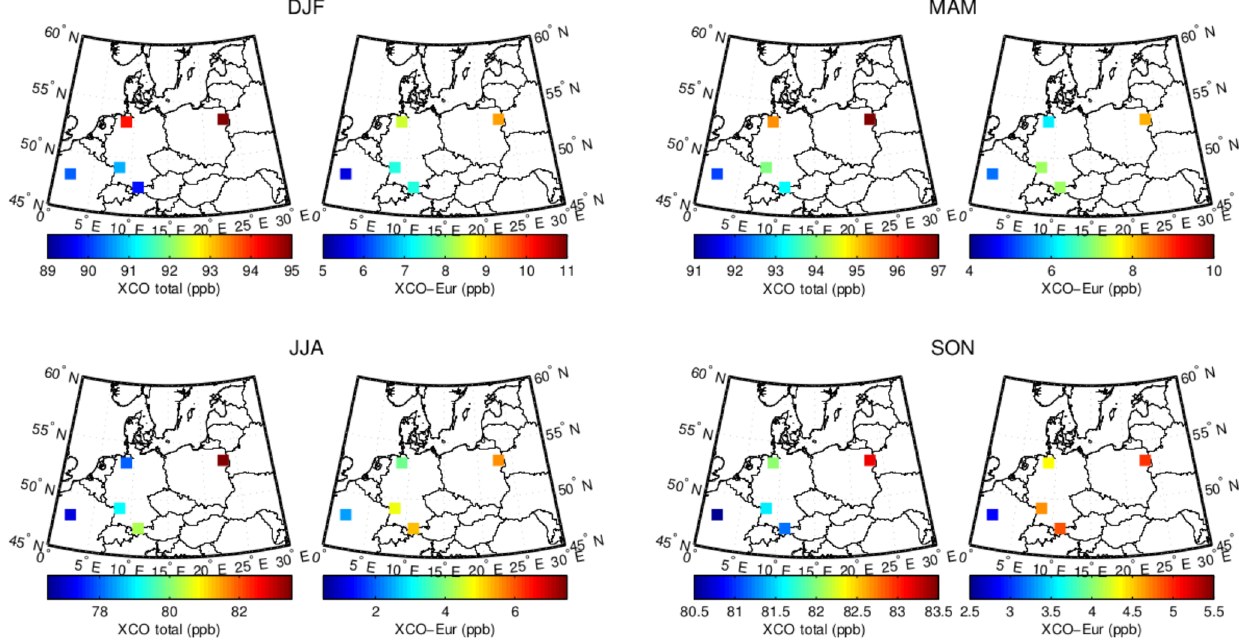
Figure 4. This figure compares seasonally averaged modeled total X CO with the X CO contribution from emissions in Europe. Each season has two maps: the left map shows the total X CO and the right map shows the contribution from European emissions (X CO − Eur ). The spatial pattern of the gradients in modeled X CO between the TCCON stations is reflected in the European